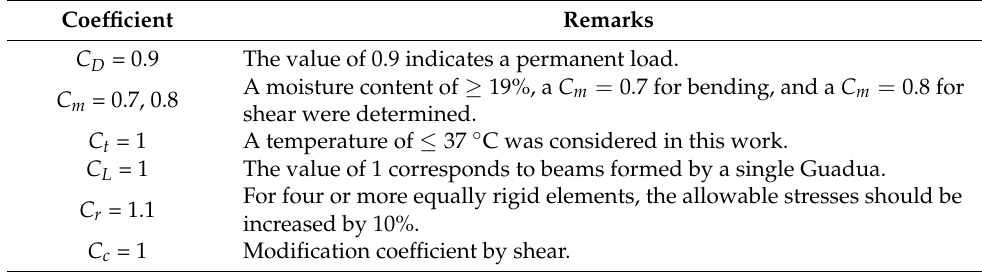
Table 4. Modification coefficient